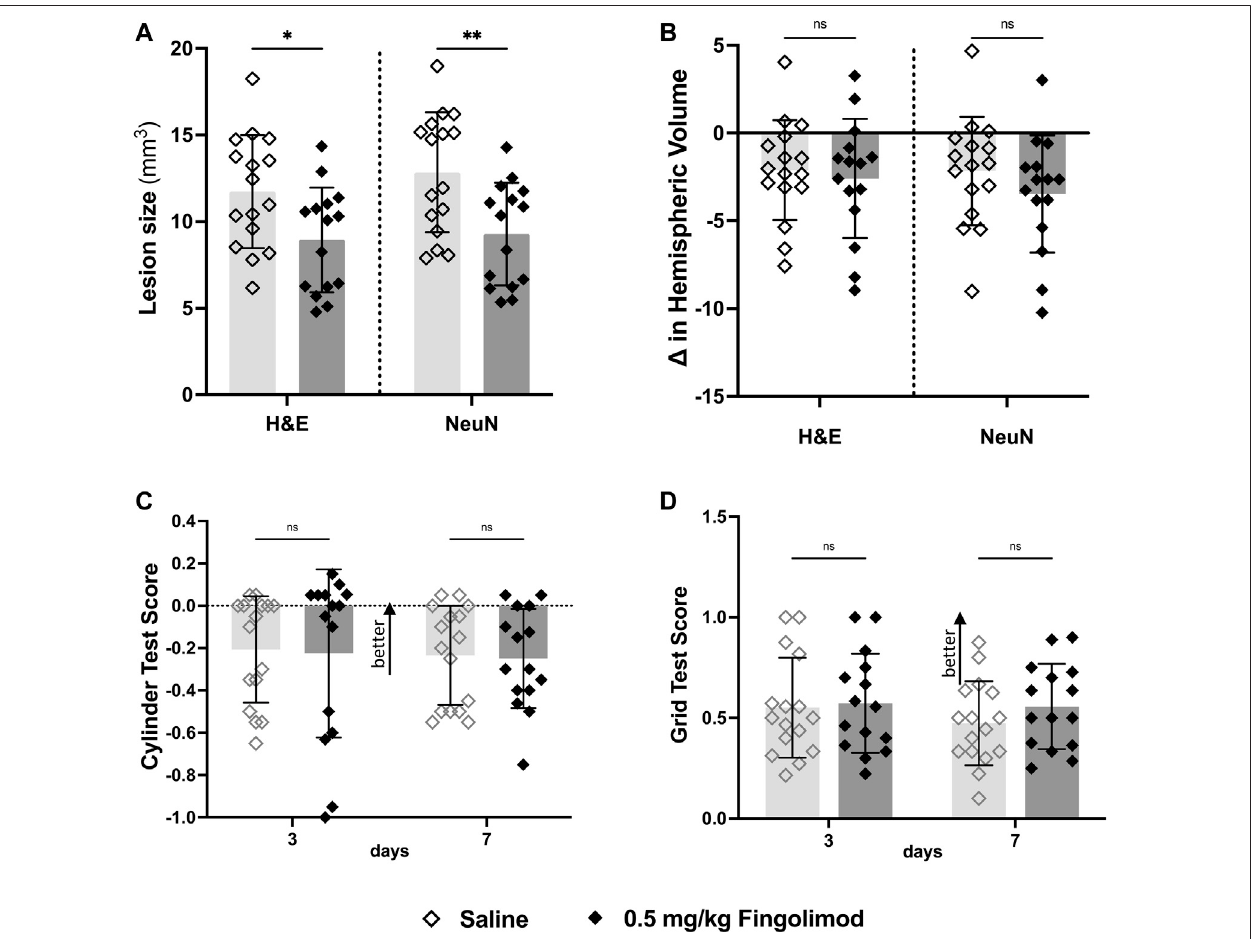
FIGURE4| Atheroscleroticmousestudy — (A) Lesionsizemeasurementsbystainingmethod; fi ngolimod(0.5 mg/kg)treatedmicehadasmallerlesionsize7 days after stroke compared to saline for both staining methods. (B) Difference in volume between brain hemispheres; there was no difference in the hemispheric volumes between treatment groups (C) Cylinder test results at 3- and 7-days post-stroke arranged by treatment group (negative scores represent preference for the left paw usage(ipsi)); there wasno difference in scores over time. (D) Grid walking test scores(scores closer to1represent amore comparable number ofmissed steps on eachside)totherewasnodifferenceovertimeorbetweentreatmentgroups ◇ Saline( n =16) ◆ 0.5 mg/kg fi ngolimod( n =15).Mean±SD;ns-notsigni fi cant;* p < 0.05; ** p < 0.005; *** p < 0.0005.